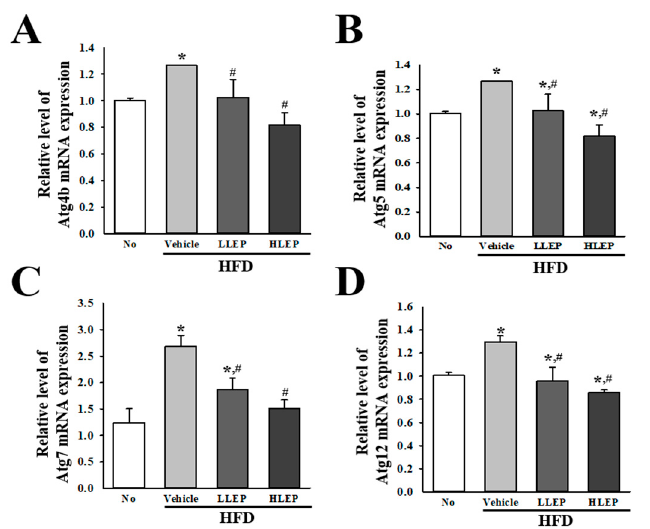
Figure 7. Transcription of autophagy-related genes in liver tissue. HFD-induced obesity C57BL / 6N mice were treated with No, Vehicle, LLEP, or HLEP for 16 weeks. After purification of total RNA, the levels of ( A ) Atg4b, ( B ) Atg5, ( C ) Atg7, and ( D ) Atg12 mRNA in the total transcripts of liver tissue were measured by RT-qPCR analyses using their specific primers. The relative levels of the Atg4b, Atg5, Atg7, and Atg12 mRNA were calculated based on the intensity of β -actin as an endogenous control. Three to five mice per group were used in the preparation of the total RNAs, and RT-qPCR analysis was assayed in duplicate for each sample. Data represent the mean ± SD. * p < 0.05 compared to the No-treated group. # p < 0.05 compared to the HFD + Vehicle-treated group. Abbreviations: HFD, high-fat diet; RT-qPCR, reverse transcription-quantitative polymerase chain reaction; LLEP, low concentration of LEP; HLEP, high concentration of LEP.